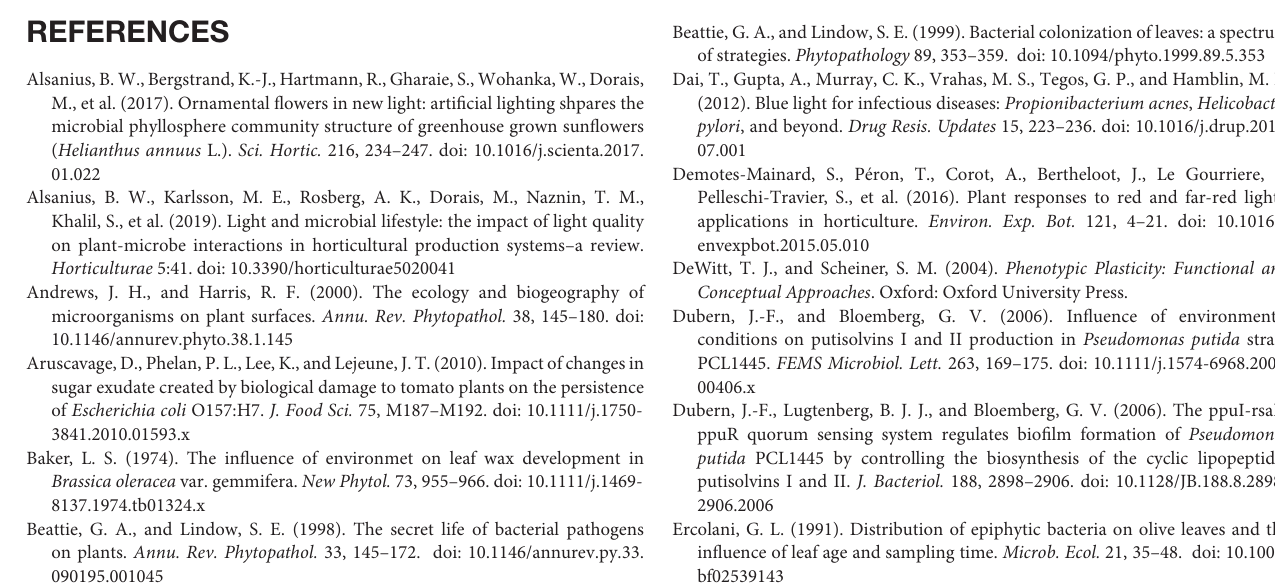
Supplementary Figure 2 | Experimental set-up for screening for biosurfactant formation and ranking scheme for drop collapse (0–3; with 0 = convex droplet, no biosurfactant formation; 1 = moderately convex droplet, moderate biosurfactant formation; 2 = flattened droplet, biosurfactant formation) (illustration: BA). Supplementary Table 1 | Substrate overlay on the four selected PM panels (PM1, PM2, PM3, and PM4 according to Biolog Inc., Haywood, United States). Supplementary Table 3 | Substrate names from Figure 4 . Substrate names are listed bottomup, as they occured as the Y-axis labels in the respective